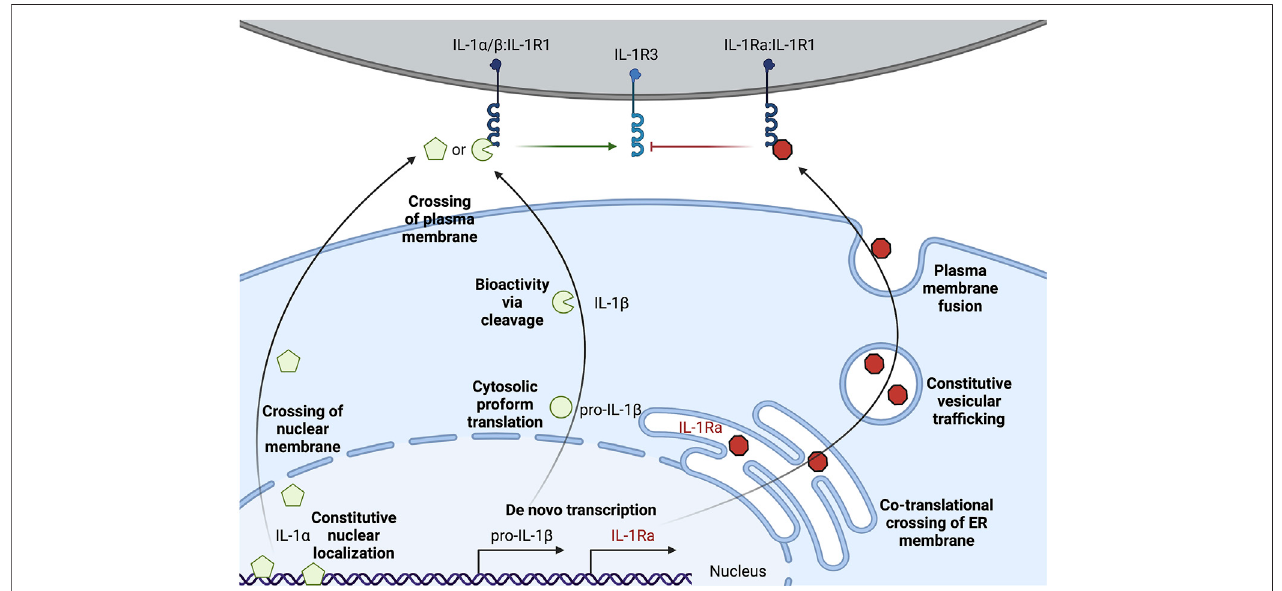
FIGURE1| Multi-levelregulationofunconventionalsecretionofIL-1.IL-1 α canbeconstitutivelyexpressed,butaccumulatesinthenuclearcompartment.Secretion requires crossing the topological barriers of the nuclear membrane and the plasma membrane. Proform IL-1 α is biologically active on the IL-1 receptor complex, but cleavagebycertainproteases suchascalpainscanincreaseactivity. Pro-IL-1 β isoftentranscriptionallyinduceduponsensationoflowerlevelthreatstothehostsuchas extracellular PAMPs or pro-in fl ammatory cytokines. Pro-IL-1 β is translated and remains in the cytosol, and must cross the topological barrier of the plasma membrane for secretion. Cleavage of pro-IL-1 β by proteases such as caspase-1 is required for bioactivity on the IL-1 receptor complex. IL-1Ra is the only IL-1 family memberthatisconventionallysecretedthroughthebiosyntheticpathway.IL-1Raistranscriptionallyinducedalongsidesensationofin fl ammatorycuesandconventional secretion of this cytokine may buffer the action of pro-in fl ammatory IL-1 α /IL-1 β by blocking their interaction with IL-1R1.